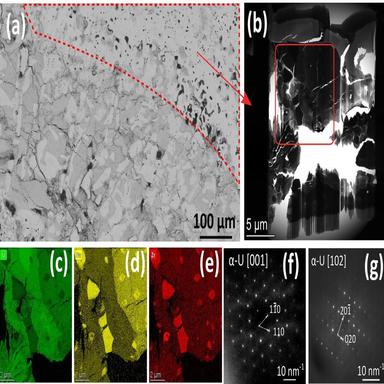
Radial zone 2 is showing the single-phase matrix (dashed region in a), STEM image (b) shows the microstructure can be porous underneath the surface; STEM-EDS mapping of U (c), Pu (d), and Zr (e) shows that the matrix is rich in U and the precipitates are rich in Zr and Pu, SAED patterns indexing shows the matrix is isostructural to α-U (f-g).